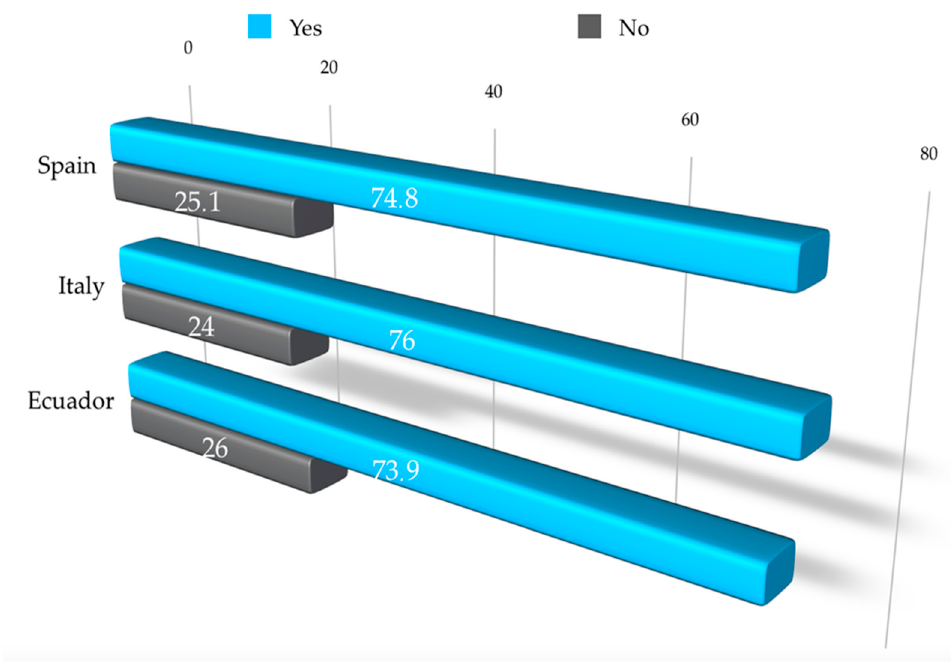
Figure 5. Students’ confidence about their own digital competence and skills.